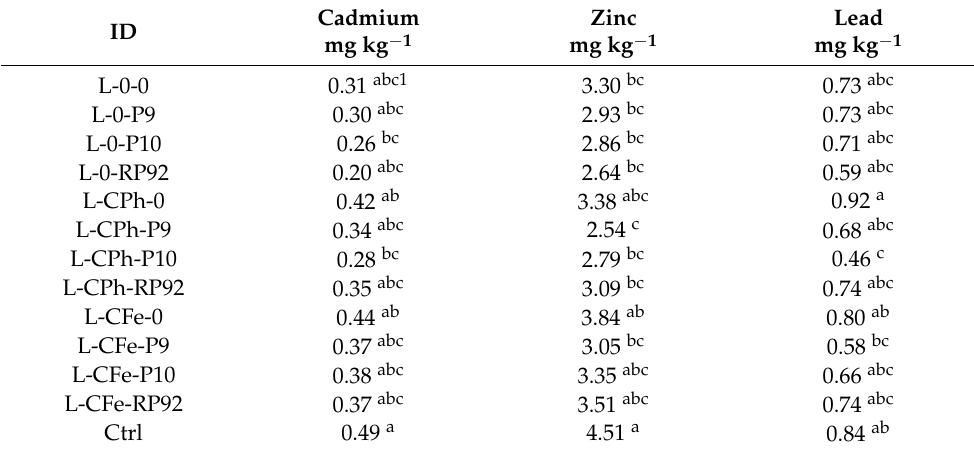
Table 5. Metals extractable in 1 M NH 4 NO 3 as dependent on the remediation treatment. ID